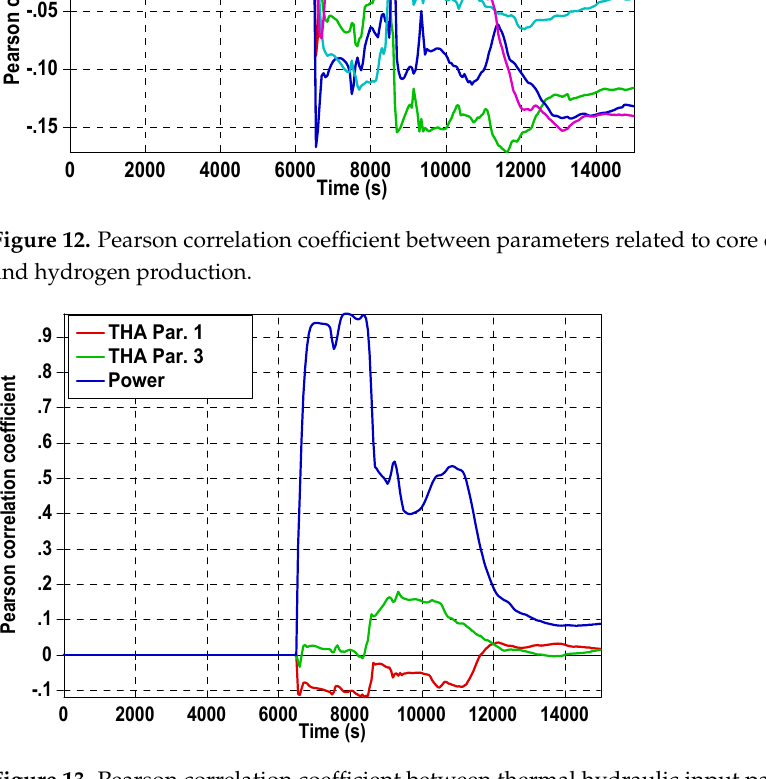
Figure 13. Pearson correlation coefficient between thermal hydraulic input parameters and hydro- gen production.